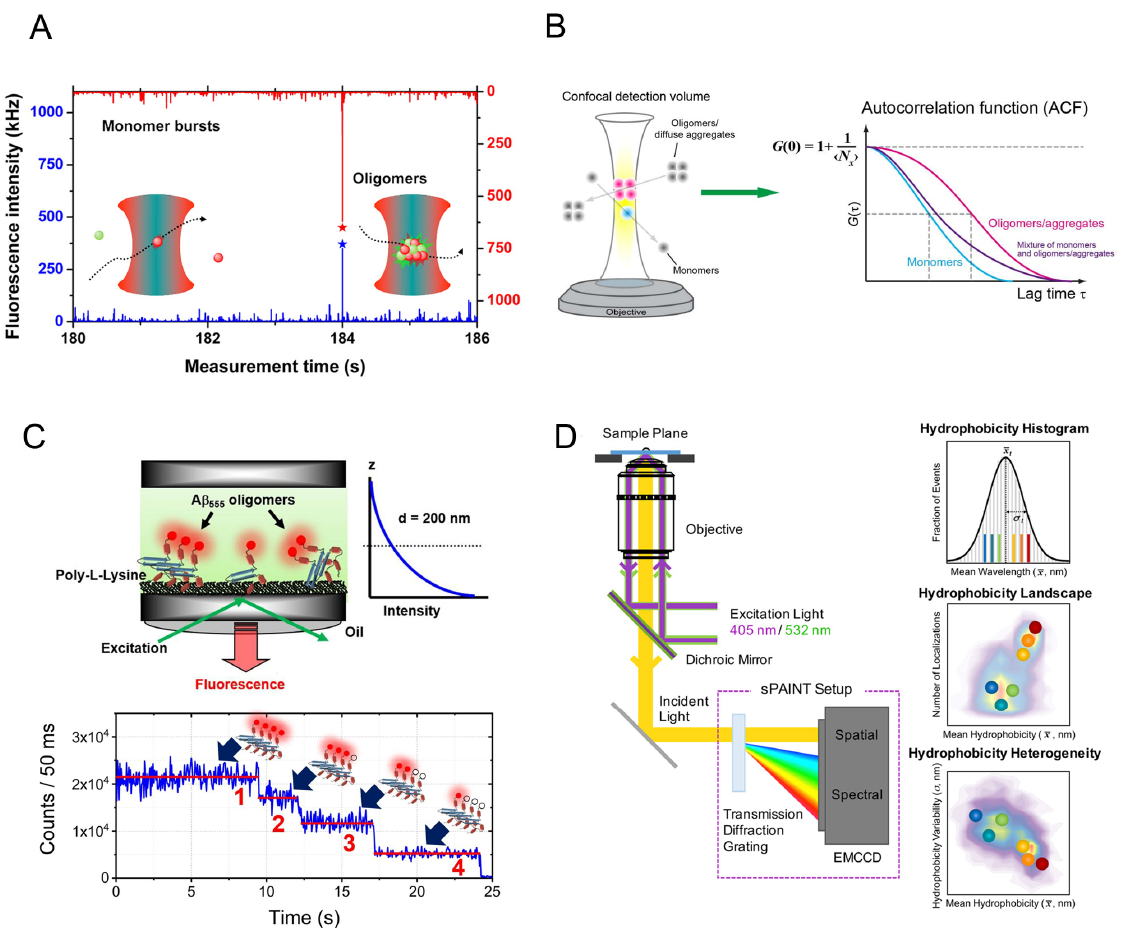
Figure 1. Overview of single molecule fluorescence methods for detecting amyloid oligomers. ( A ) Confocal two-color coincidence detection (TCCD) of amyloid oligomers. Formation of oligomers by donor and acceptor labeled monomers can generates coincident bursts in both detection channels when diffusing across the focal volume. Figure reproduced from ref. [59] with permission. (Copyright (2008) National Academy of Sciences.) ( B ) Fluorescence correlation spectroscopy (FCS) measurements of fluorescence-labeled monomers and oligomers which show different diffusion times (DT) in the autocor- relation curves. Figure adapted from ref. [36] with permission. ( C ) Single molecule total internal reflection fluorescence (TIRF) imaging of surface-immobilized amyloid oligomers. The fluorescent sample is excited by the exponentially decaying evanescent field at the coverslip-sample interface. The single molecule photobleaching steps can be counted to determine the oligomer size. Figure adapted from ref. [73] with permission. ( D ) Single molecule spectrally-resolved points accumulation for imaging in nanoscale topography (sPAINT) setup for super-resolution imaging of individual amyloid oligomers as well as the surface hydrophobicity properties. Figure reproduced from ref. [68] with permission. (Further permissions related to this figure should be directed to the ACS. Original figures at: